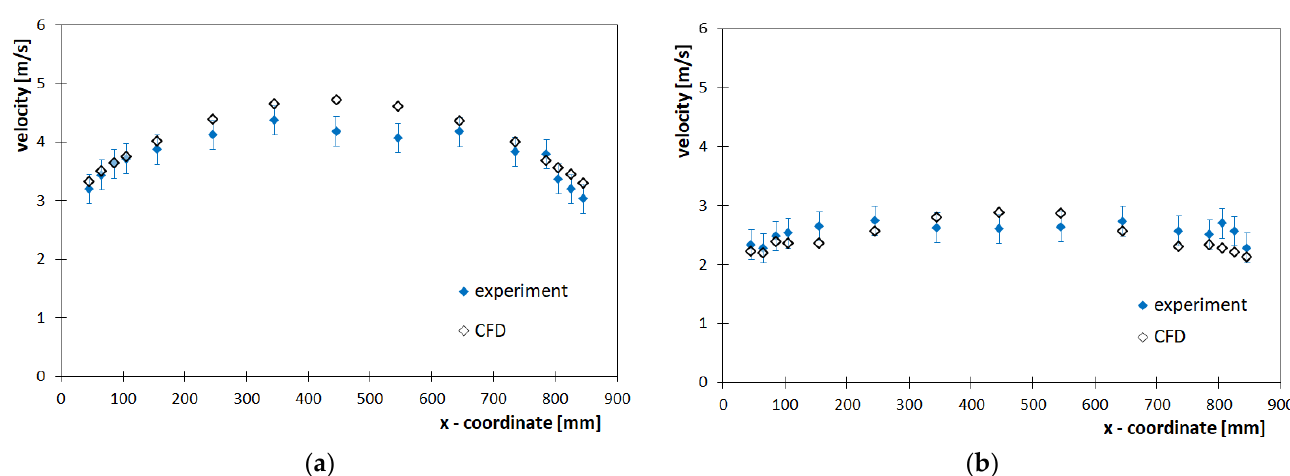
Corresponding Δ p = 100 Pa. Corresponding ∆ p = 100 Pa.